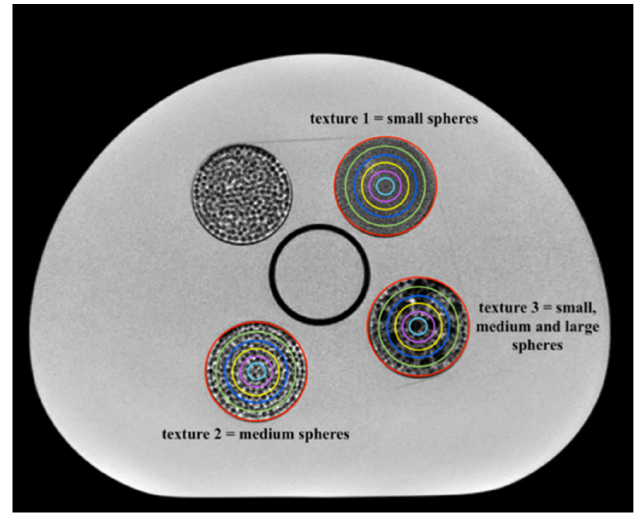
Figure 1. MR representation of the inserts embedded in the phantom, with corresponding textures and VOIs placement. Three phantom inserts were chosen as representative of three textures, from a finer texture (1) to a coarser one (3) through a medium texture (2). The volumes of the selected VOIs were: 29.8 cm 3 (red), 20.7 cm 3 (green), 13.3 cm 3 (blue), 7.4 cm 3 (yellow), 3.3 cm 3 (pink), and 0.8 cm 3 (cyan). Window width/window level for the image: 1970/1165.